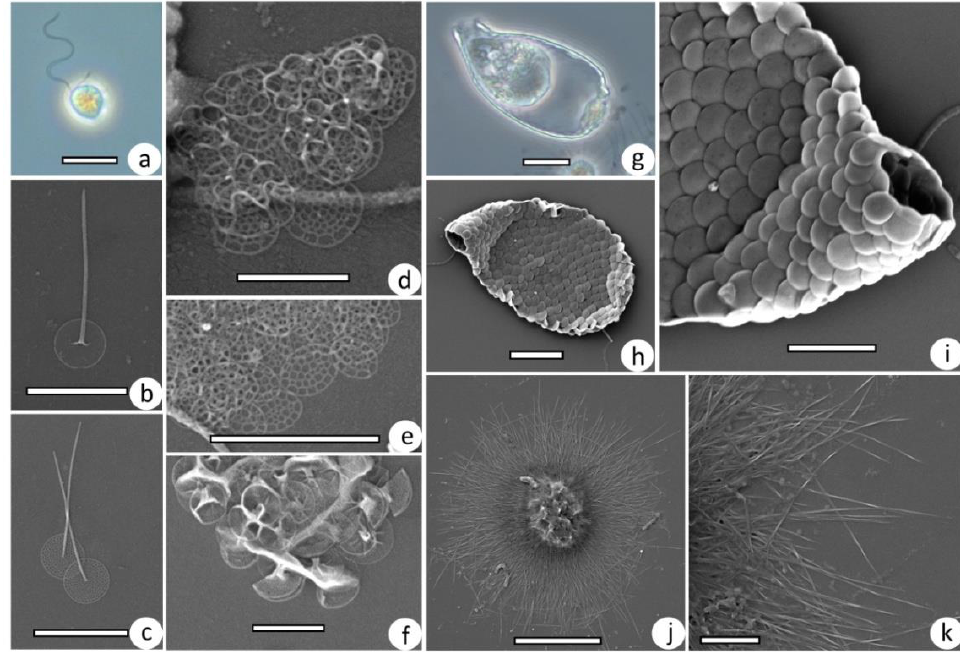
Figure 4. Morphology of the observed protists with external scales: ( a ) Paraphysomonas sp. (LM); ( b ) Paraphysomonas vestita ; ( c ) Paraphysomonas foraminifera ; ( d , e ) Clathromonas butcheri ; ( f ) Paraphysomo- nas cylicophora ; ( g – i ) Cyphoderia aff. littoralis (LM — g ; SEM — h , i ; h — shell; i — detail of the scales ar- rangement); ( j , k ) Heterophrys -like organism. Scale bars: 1 µm — d , f ; 2 µm — b , c , e , k ; 5 µm — i ; 10 µm — a , g , h , j .